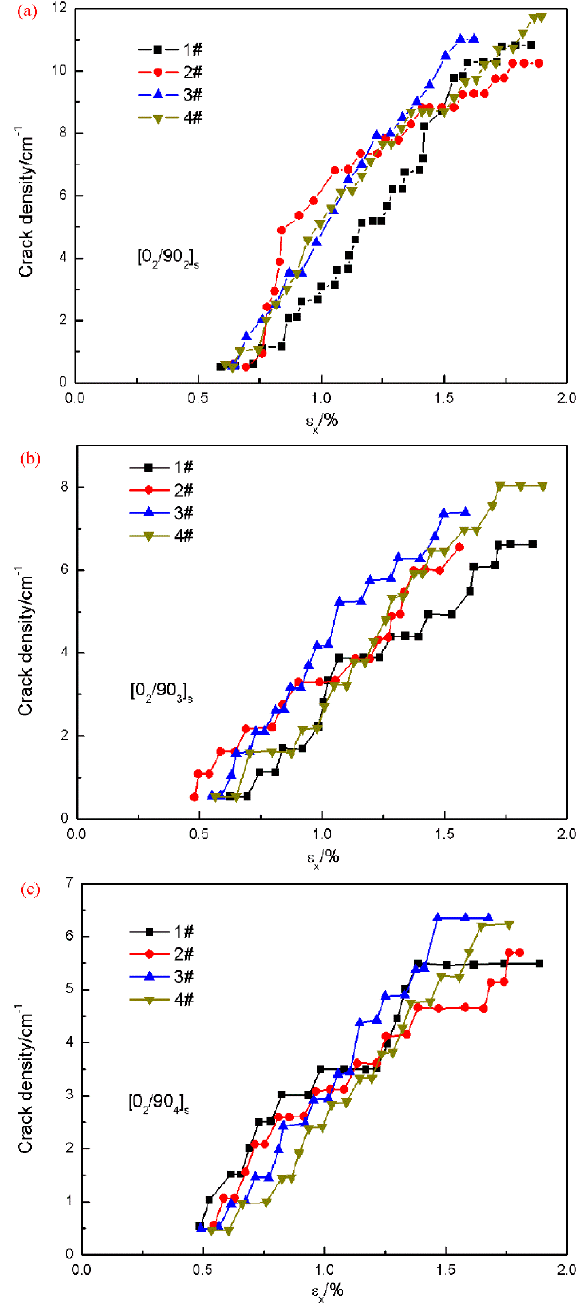
Figure 8. The experimentally observed crack density of the cross-ply [0 2 / 90 n ] s (n = 2,3,4) laminates under longitudinal uniaxial tension load. ( a ) [0 2 / 90 2 ] s laminates; ( b ) [0 2 / 90 3 ] s laminates; ( c ) [0 2 / 90 4 ] s laminates.